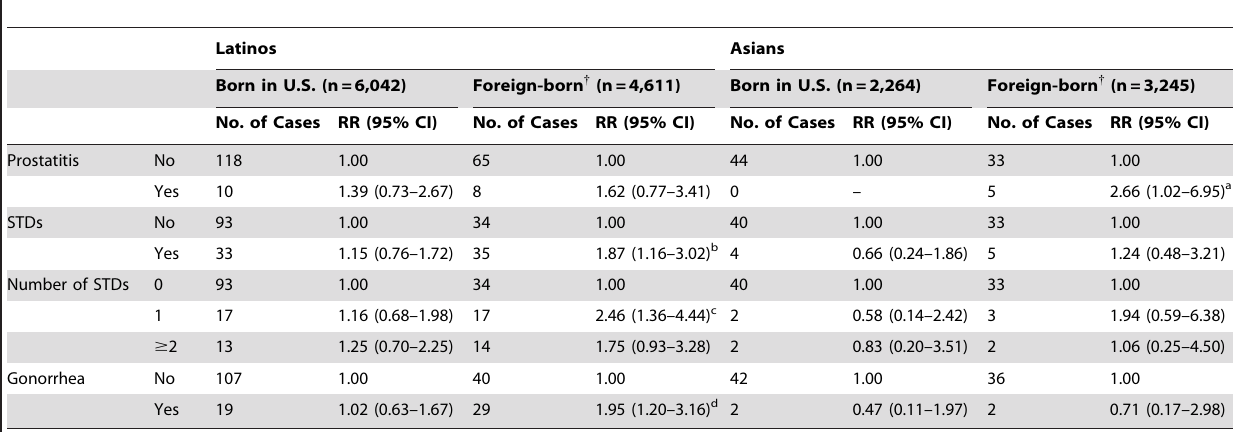
Table 5. Latino relative risks and 95% CIs of prostate cancer associated with prostatitis and STD history by place of birth, California Men’s Health Study, 2002–2006.